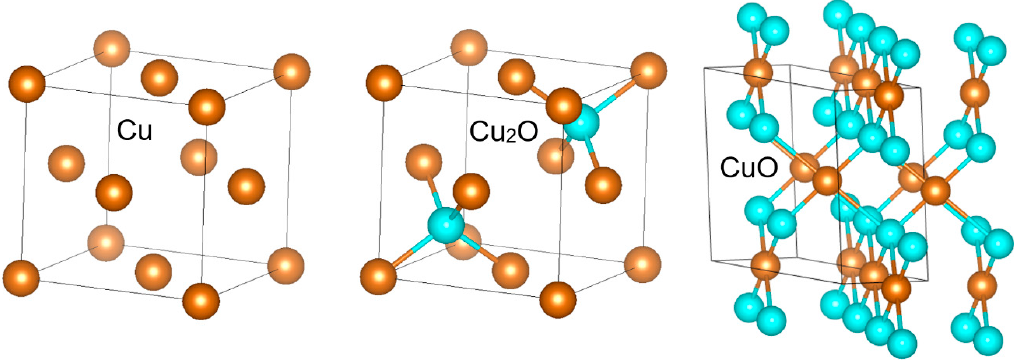
Figure 5. Comparison of Cu, Cu 2 O and CuO crystal structures.